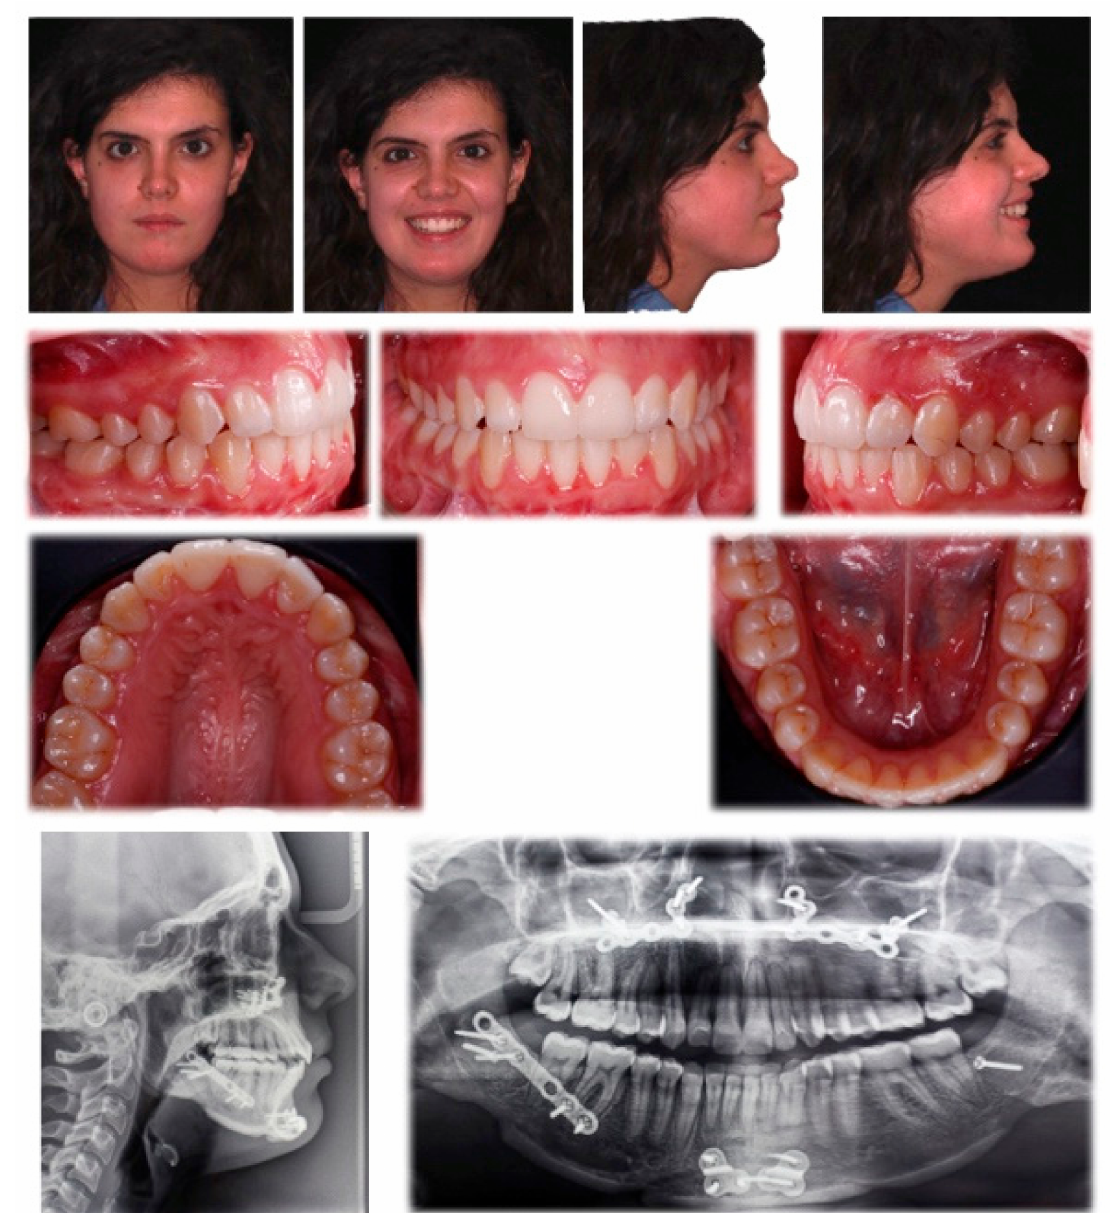
Figure 6. Post Treatment Records. Patient after 15 months of